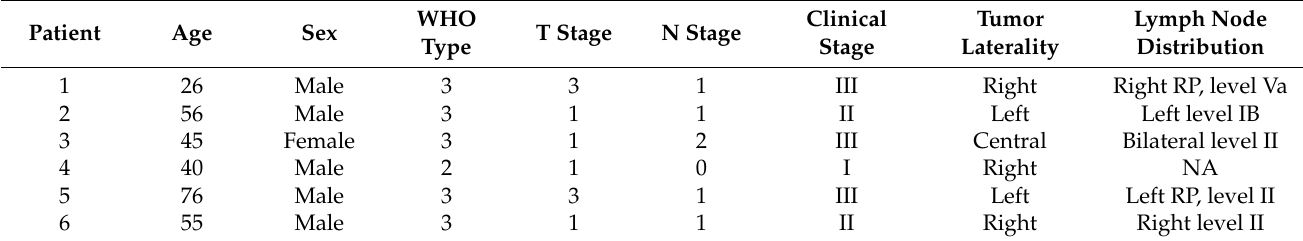
Table 1. Patient characteristics and tumor characteristics.